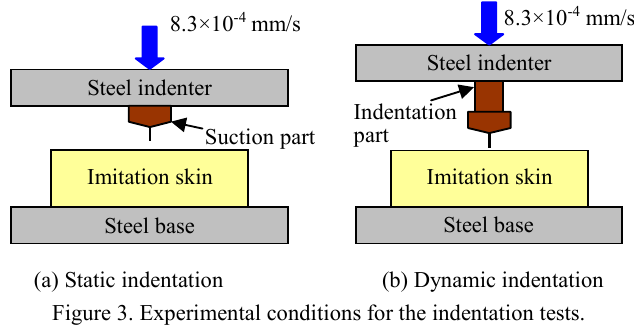
Figure 3. Experimental conditions for the indentation tests.